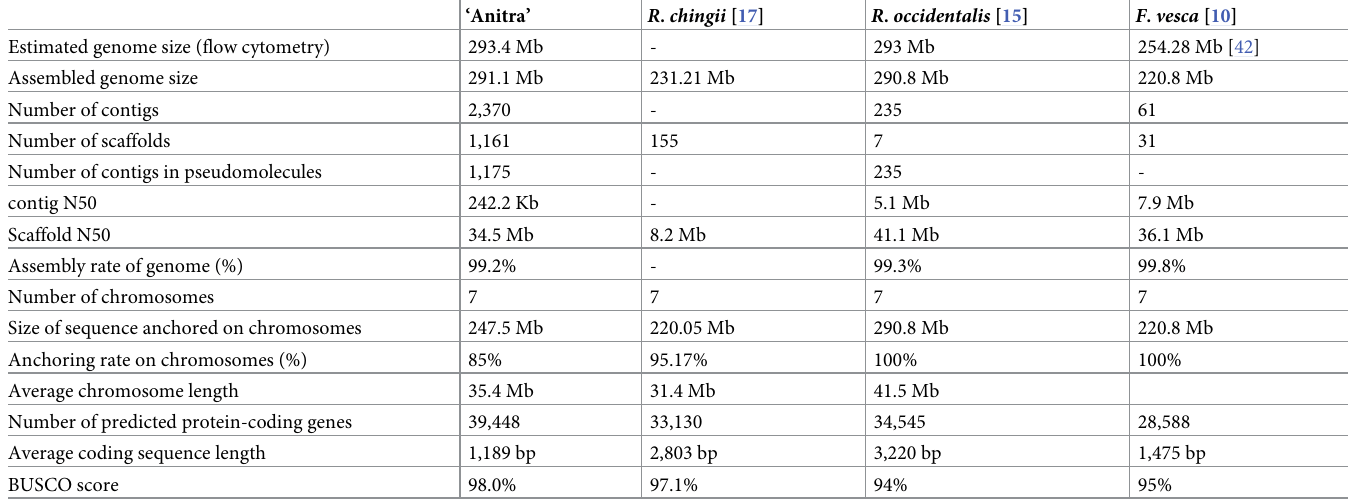
Table 2. Comparison of assembly statistics for R . idaeus cv. ‘Anitra’ and three closely-related Rosoideae genome